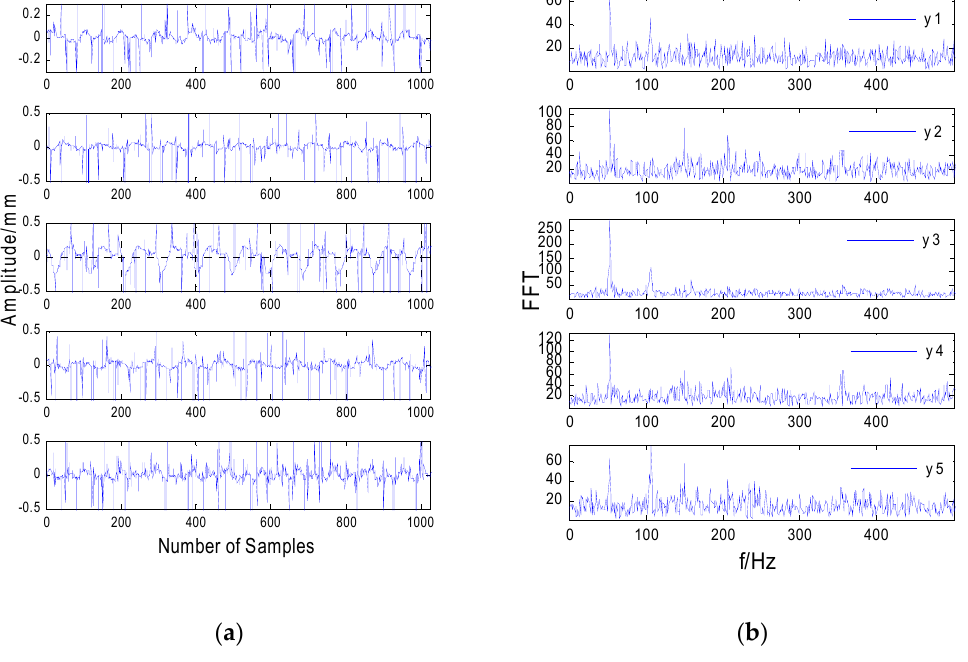
Figure 4. Time-frequency waveforms of rotor vibration signals. ( a ) The time-domain signals. ( b ) The frequency-domain signals.